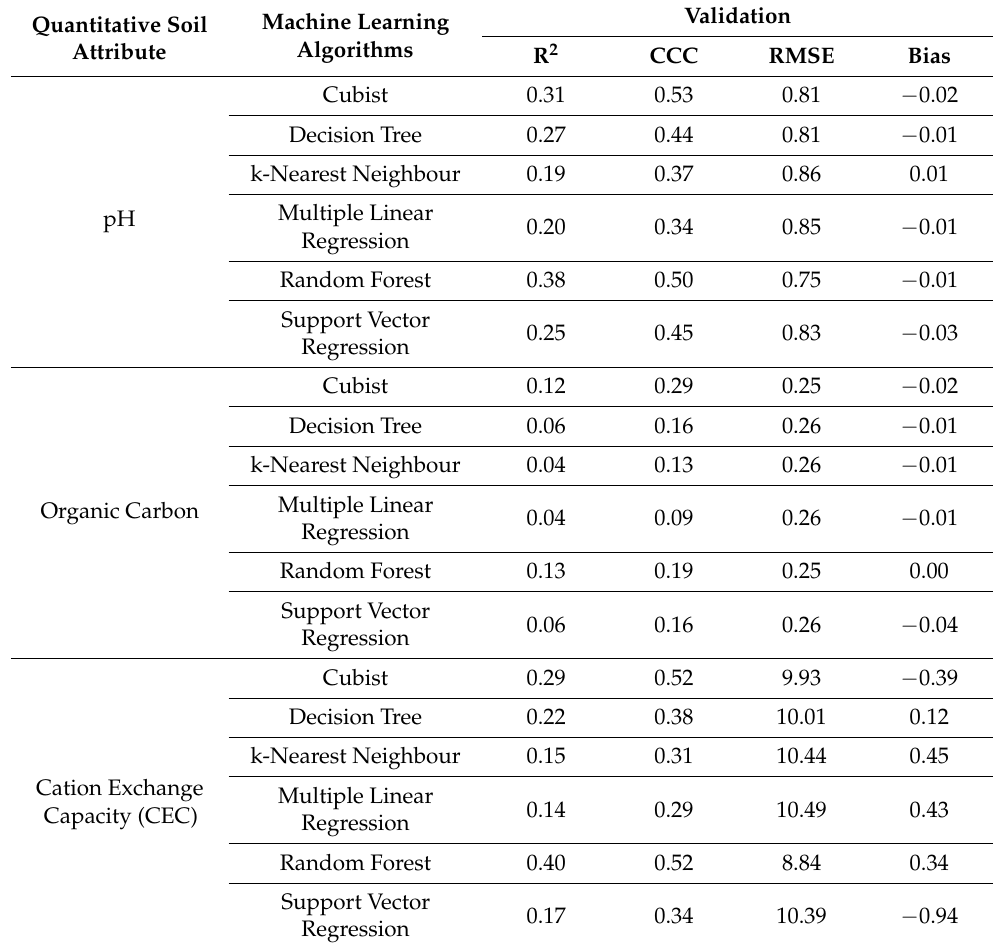
Table 4. Prediction evaluation metrics assessed for continuous soil